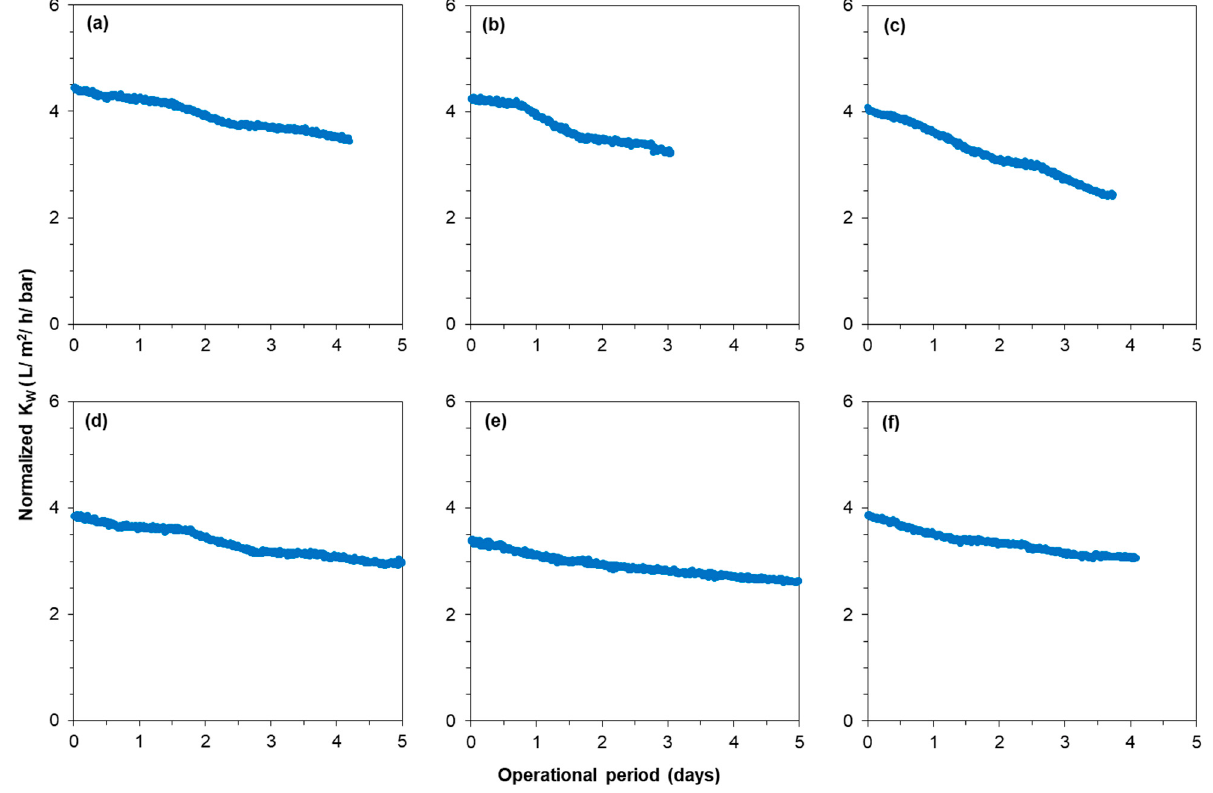
Figure 9. Average normalized permeability of the last stage of the RO unit at 85% recovery ( a ) without antiscalant, ( b ) with 2.5 mg/L AS–1, ( c ) with 2.5 mg/L AS–2, ( d ) with 2.5 mg/L AS–3, ( e ) with 5 mg/L AS–4, and ( f ) with 5 mg/L AS–5.